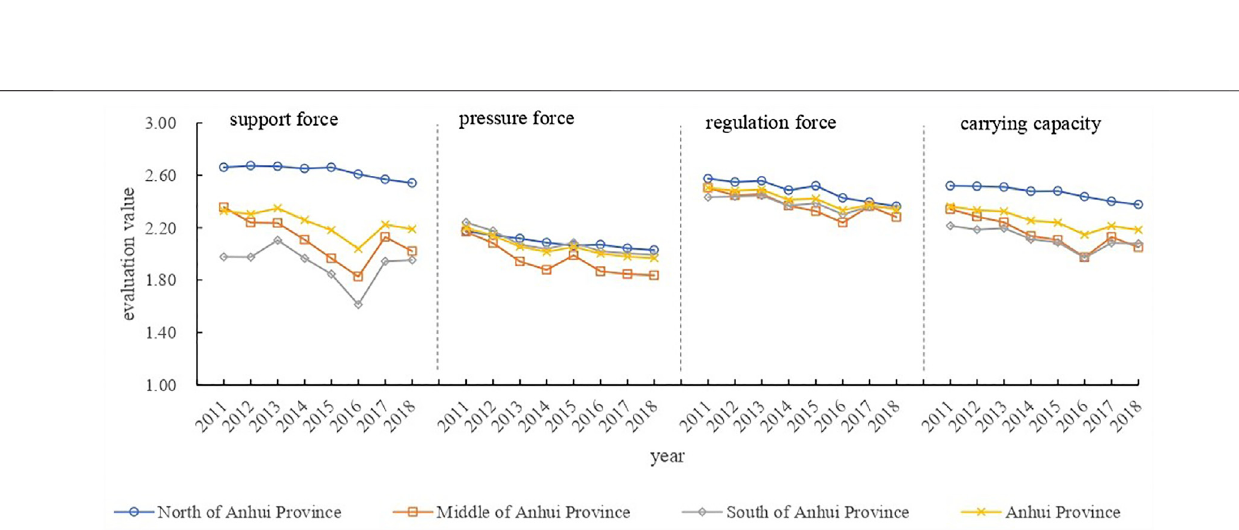
Frontiers in Earth Science |